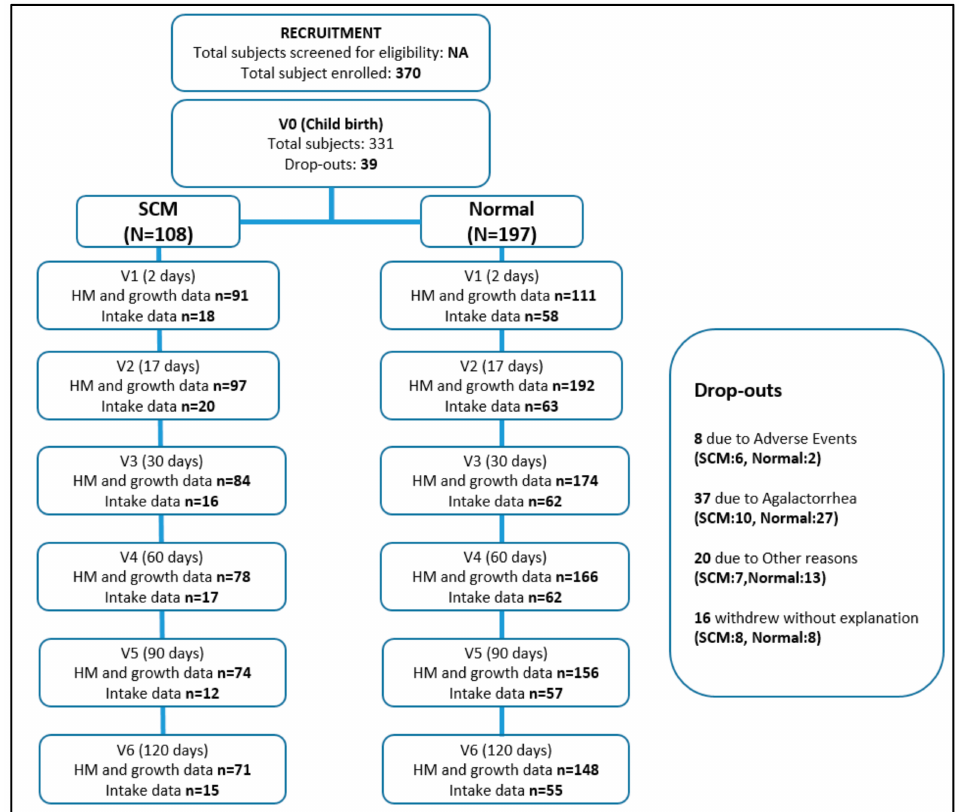
Figure 1. Flowchart outlining number of mothers per group at each visit. The Subclinical mastitis (SCM) group in this flowchart indicates mothers with at least one incident of SCM in the first